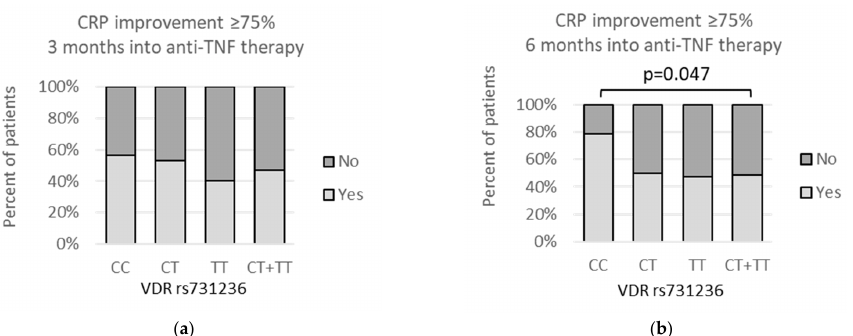
Figure 6. Relationships between VDR rs731236 genetic variants and percent of patients achieving CRP improvement ≥ 75% after ( a ) 3 months of anti-TNF therapy and ( b ) 6 months after beginning of the treatment. The following statistically significant associations were found: ( b ) CC vs. CT + TT , p = 0.047, OR(95%CI) = 3.84 (1.03 to 13.4). Analysis was performed using Fisher‘s exact test. Although erythrocyte sedimentation rate (ESR) measurement data was collected at all three time points: at baseline, and then 3 and 6 months after beginning of the anti-TNF treatment, the relationships with any of the VDR polymorphic variants were found to be statistically significant at only one time point. Namely, the lowest ESR after 6 months of therapy was observed for the rs731236 CC homozygotes in the codominant model ( CC vs. CT : median (IQR) = 3 (2–11) vs. 8 (3–15); p = 0.017) as well as dominant model ( CC vs. CT + TT : median (IQR) = 3 (2–11) vs. 6 (3–15); p = 0.046). Relationships between VDR rs731236 genotypes and ESR levels at different time points of the treatment are shown on Figure 7.